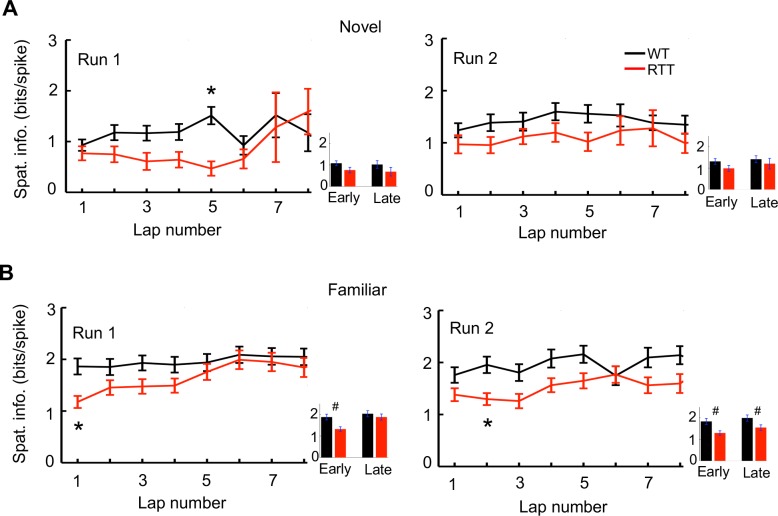
Lap-by-lap spatial information of place cells on the novel and familiar tracks.(A) Lap-by-lap spatial information in Run 1 and Run 2 on the novel track. Inset on the right of each panel: average spatial information during the early (1–3) and late (6–8) laps. *p<0.00625, Wilcoxon ranksum test with significance level adjusted for multiple (8) comparisons. Number of cells: N = 53 (WT), N = 31 (RTT). (B) Same as (A), but on the familiar track. Number of cells: N = 65 (WT), 103 (RTT). *p<0.00625; #p<0.025. Note that the spatial information of RTT cells started lower on the familiar track in both Run1 and Run 2 than that of WT cells.